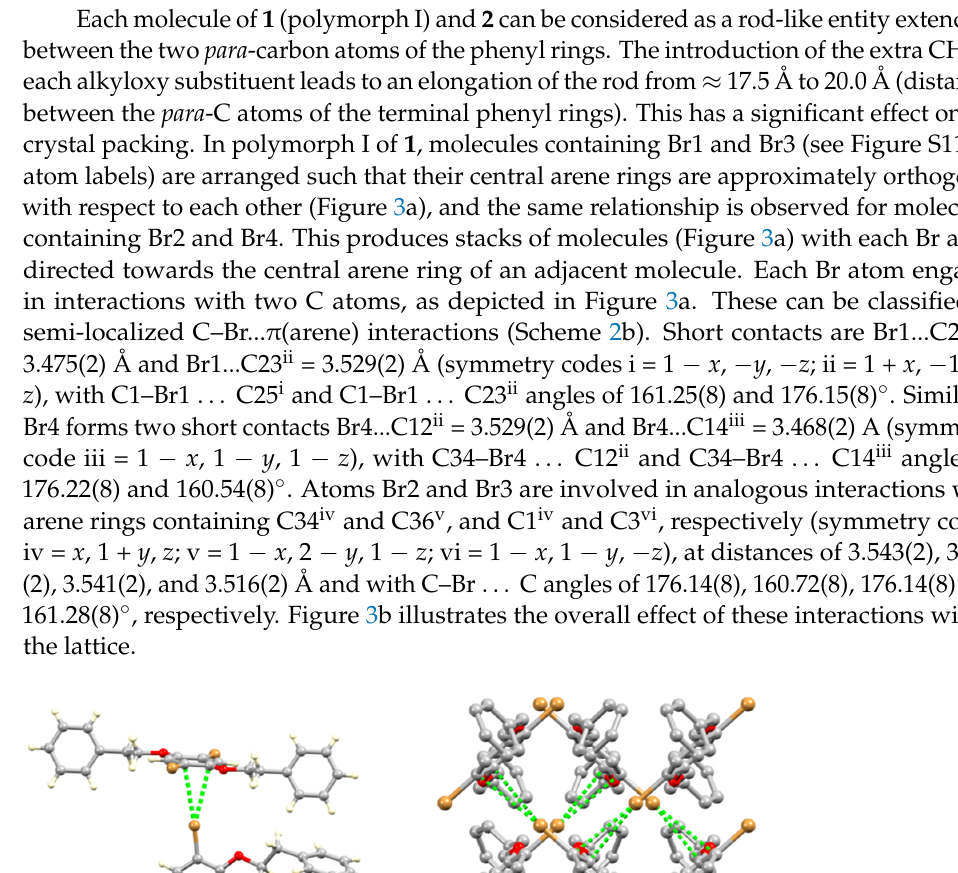
Figure 2. Molecular structures of ( a ) one of the crystallographically independent molecules of polymorph I of 1 (symmetry code i = − x , − y , − z ), and ( b ) the two independent molecules of 2 (symmetry code i = − x , 1 − y , 1 − z ). In 2 , the 3-phenylpropoxy chain with C26 is disordered and only one position is shown; see text and Figure S13. Ellipsoids are plotted at the 40% a Range of values for all four independent molecules: C–Br = 1.890(2) to 1.894(2) Å; C arene –O = 1.351(3) to 1.386(3) Å, C alkyl –O = 1.406(3) to 1.447(3) Å; probability level and H atoms are omitted for clarity. C arene –O–C alkyl = 118.3(2) to 118.57(19)°. b The corresponding angles in molecules containing Br2, Br3 and Br4 are 81.6°, 82.3°, and 81.1°, respectively (see Figures S11 and S12).